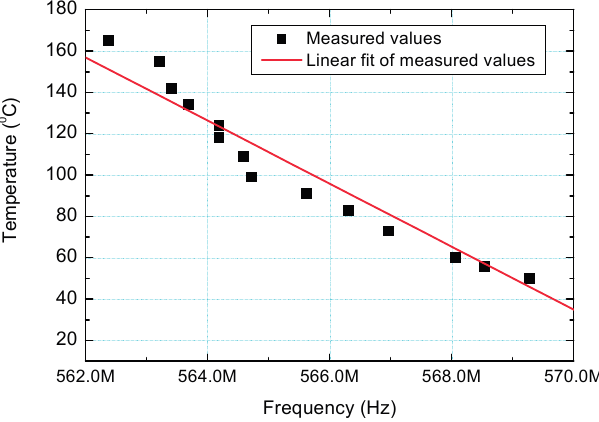
Figure 12. The temperature variation of the LC sensor as a function of resonant